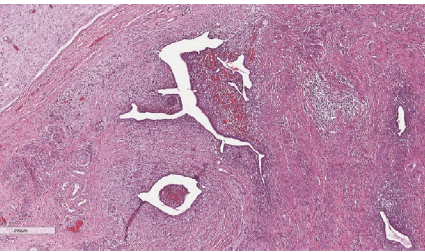
Figure 1: Microscopic examination of the labial mass reveals multiple foci of endometriosis (4x).